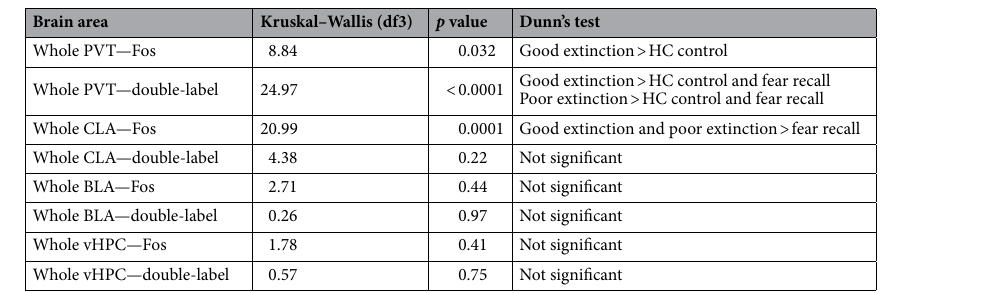
Table 1. Summary of whole area comparisons in target